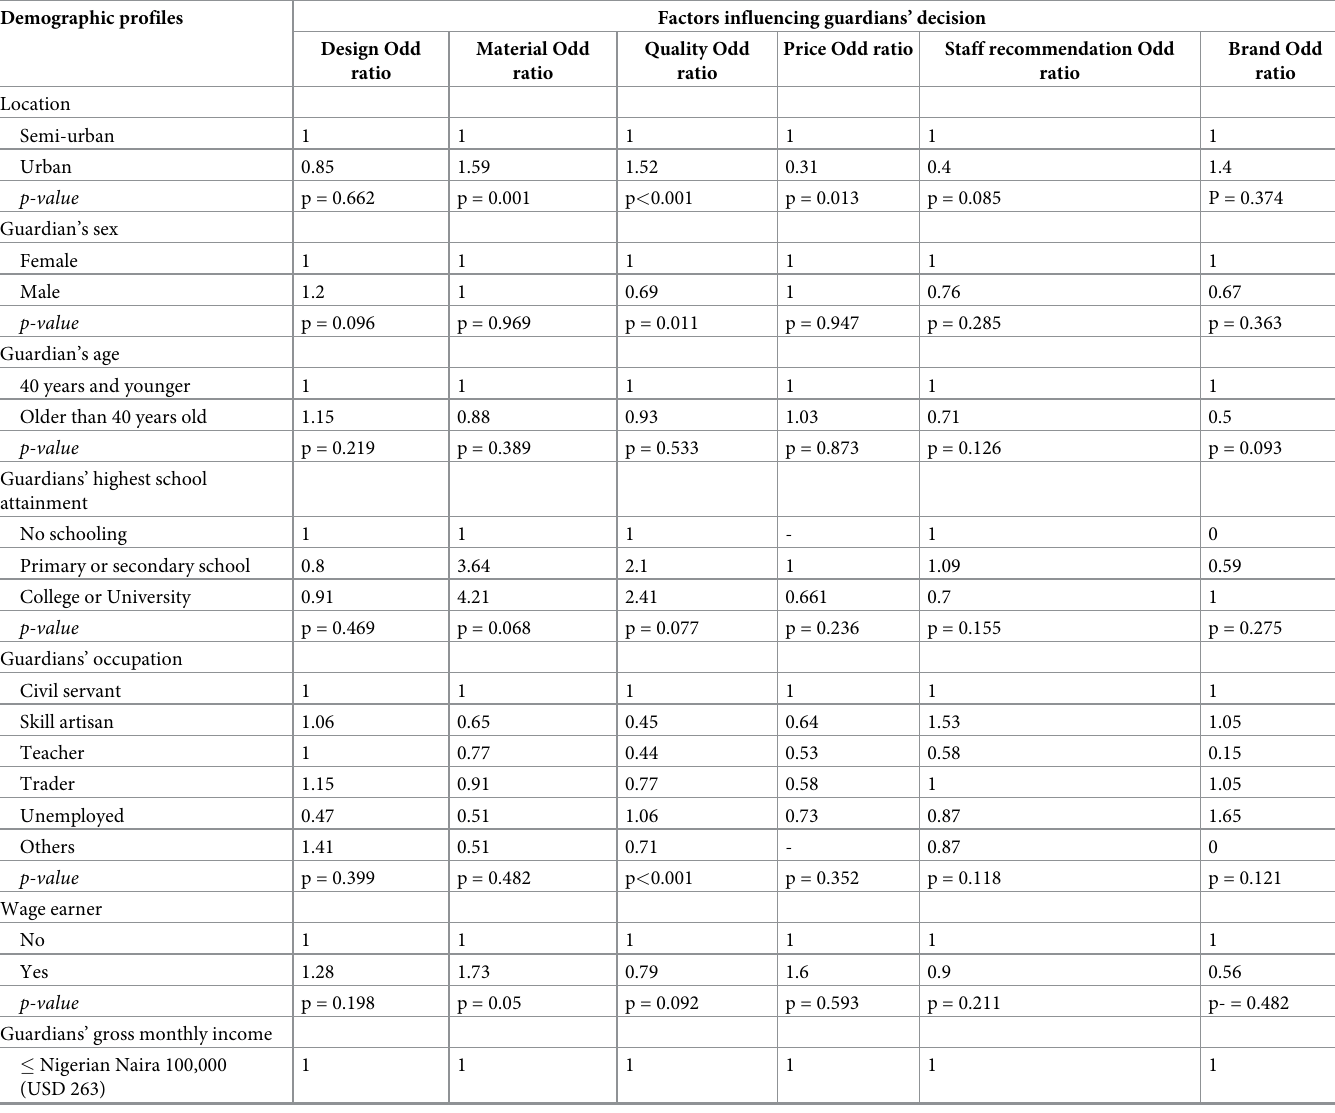
Table 4. Relationship between demography profiles and factors influencing guardians’ spectacles purchasing